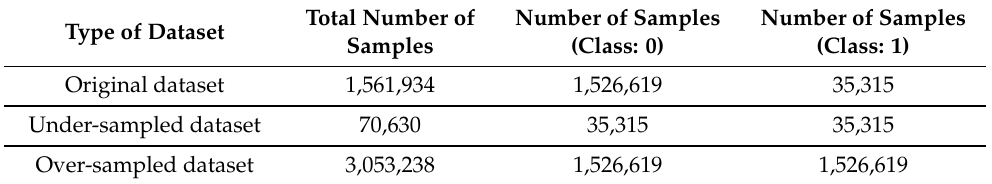
Figure 3. The distribution of benign and malicious websites in ( a ) original dataset ( b ) random undersampling dataset, and ( c ) random oversampling dataset. ( a ) The distribution of benign and malicious websites in original dataset, ( b ) The distribution of benging and malicious websites after random undersampling method was applied, ( c ) Th distribution of benign and malicious websites after the random oversampling method was applied. Table 5. The number of samples before and after the application of random undersampling and oversampling